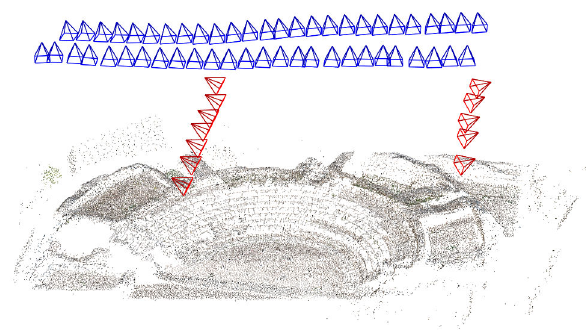
Figure 2. The UAV dataset Ventimiglia Theatre Nadiral+Oblique with 52 nadiral (blue) and 12 oblique (red) images.